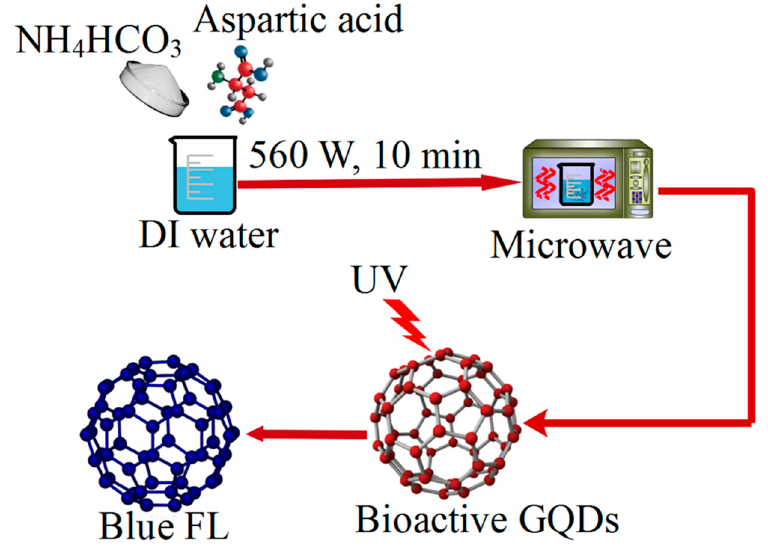
Figure 4. The purification of GQDs using microwave irradiation.